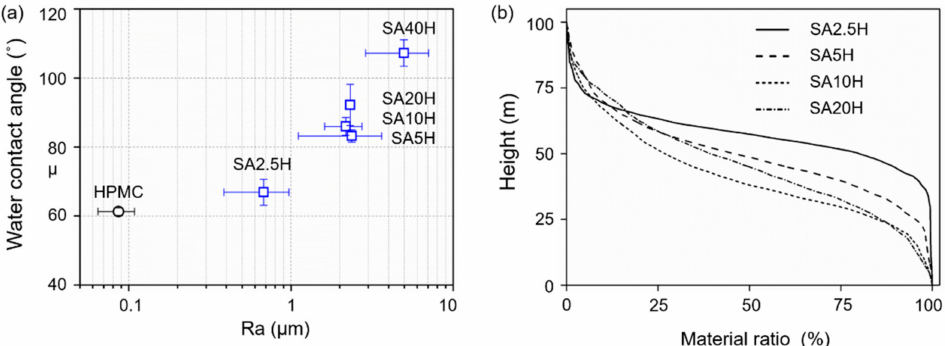
Figure 3. ( a ) Water contact angle and surface roughness, and ( b ) bearing area curve (BAC) of the dual-layer